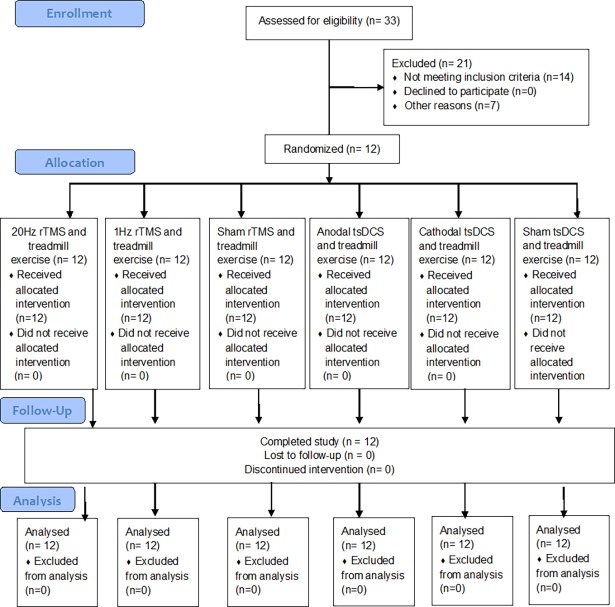
CONSORT flow diagram.TMS: Transcranial Magnetic Stimulation. tsDCS: trans-spinal Direct Durrent Stimulation.